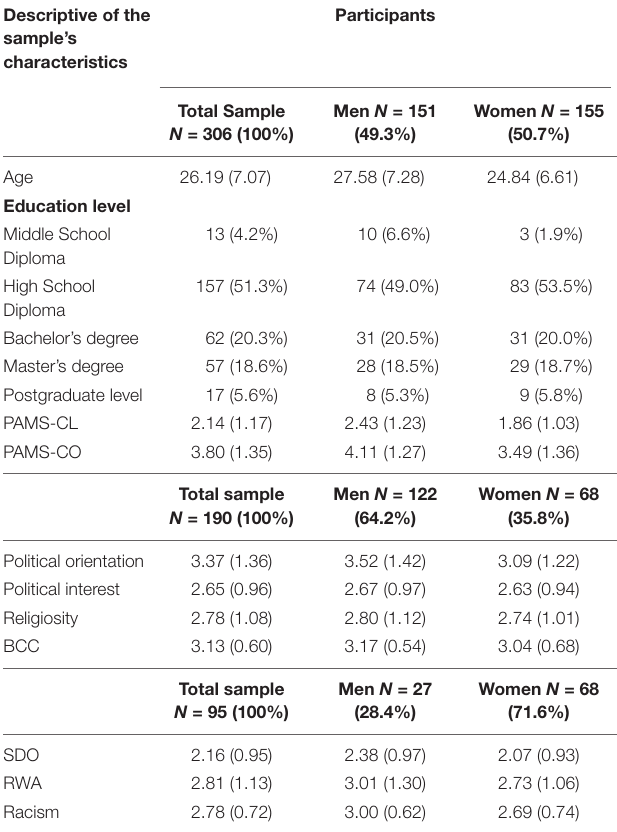
TABLE 1 | Descriptive (means, standard deviations, frequencies, and percentages) of the sample’s characteristics, divided by gender. Descriptive of the